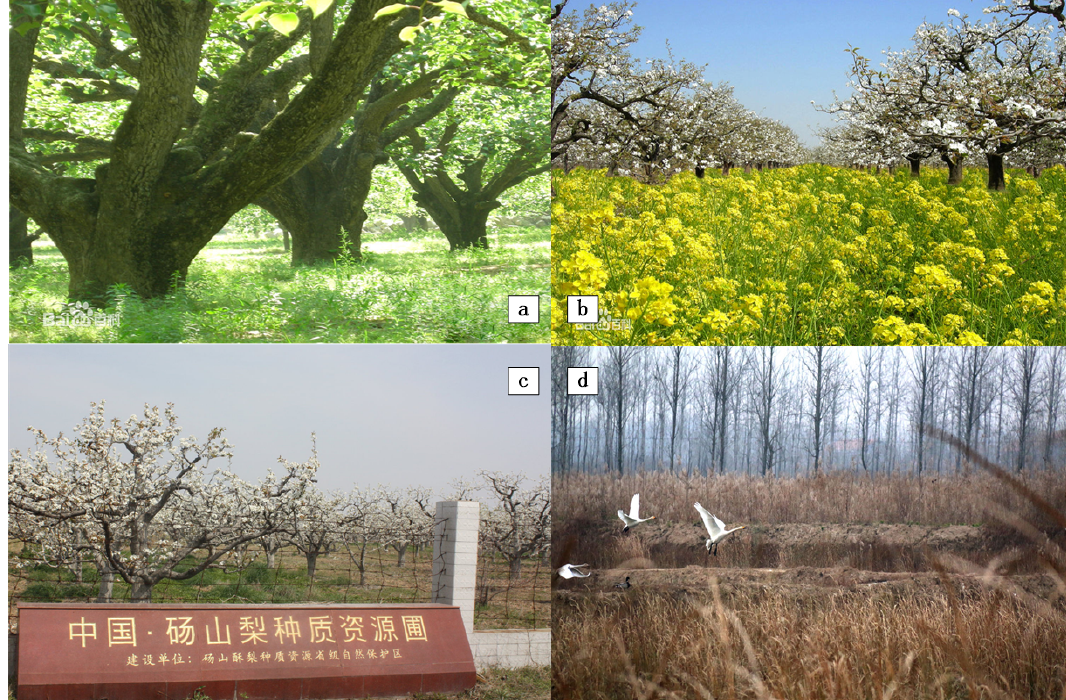
Figure 1. General situation of the Nature Reserve of Dangshan Pear Germplasm Resources. ( a ) Shows pear trees of over 100 years old; ( b ) Shows a pear orchard and farmland; ( c ) Shows pear germplasm resources repositories; ( d ) Shows the Yellow River